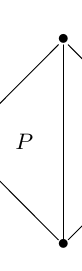
Figure 2. A topologically consistent configuration of two distinct